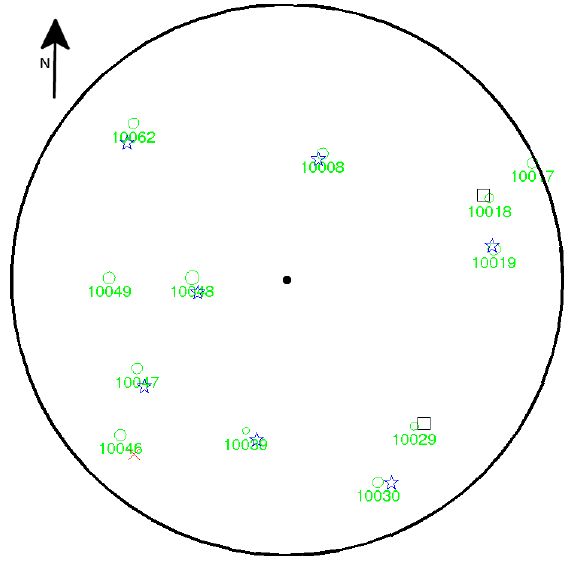
Figure 14. Results for field Plot 343. Labeling as in Figure